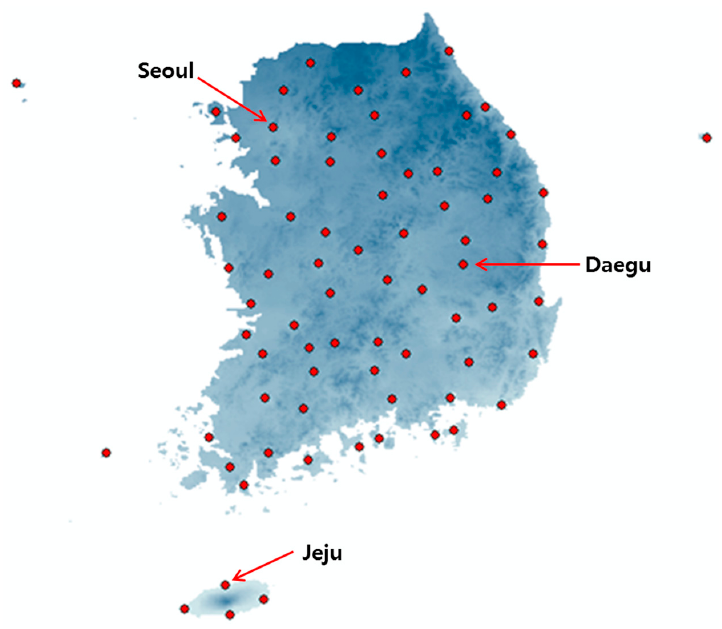
Figure 1. Main observatories in the Republic of Korea (73 sites).